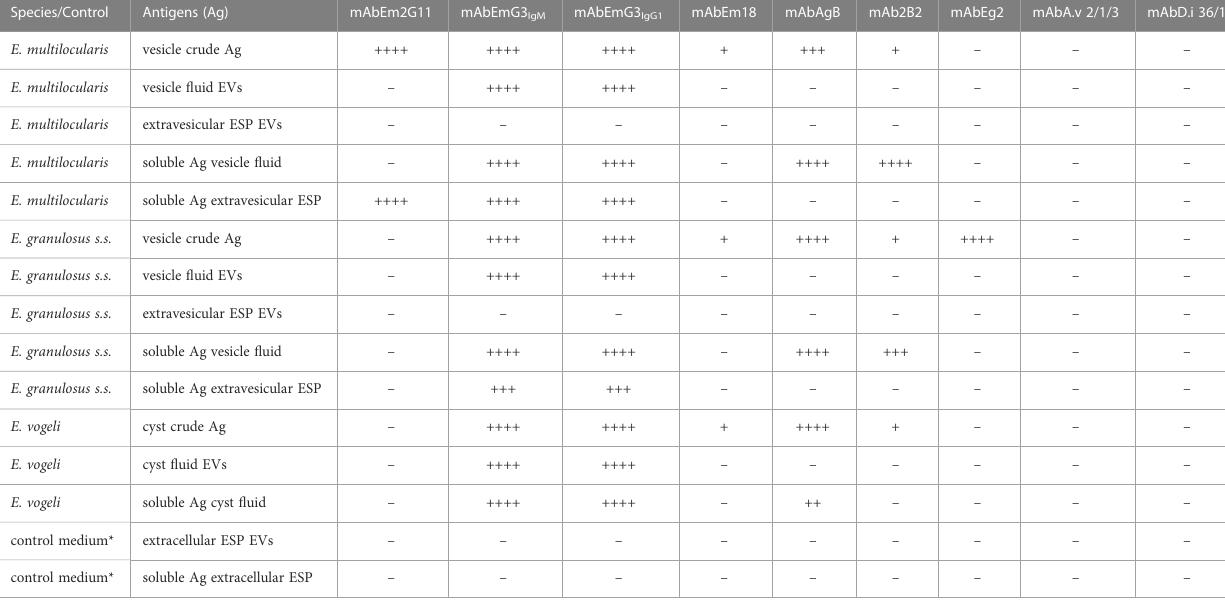
TABLE 6 Antigen binding of mAbs with puri fi ed extravesicular vesicles (EVs) and soluble excretory/secretory products (ESP) of Echinococcus species by sandwich-ELISA.